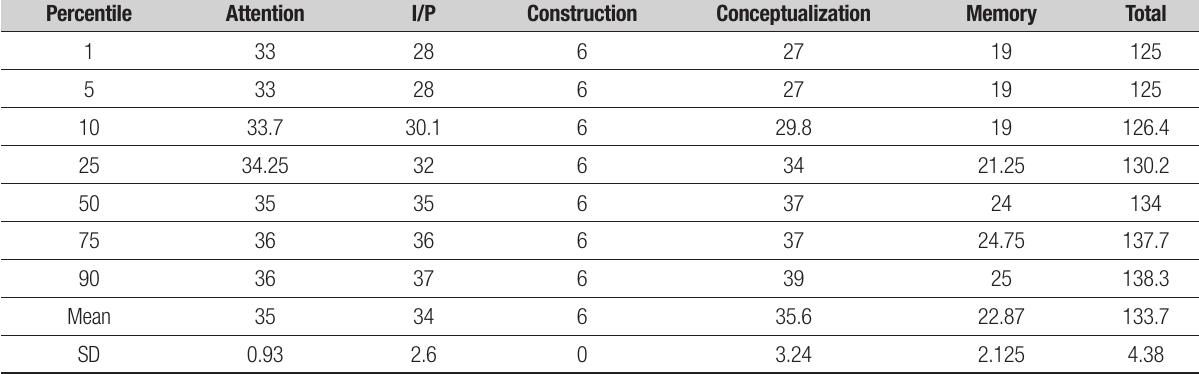
Table 3. Percentiles for subjects with 1-4 years of schooling and 50 to 60 years of age (n=16). Percentile Attention